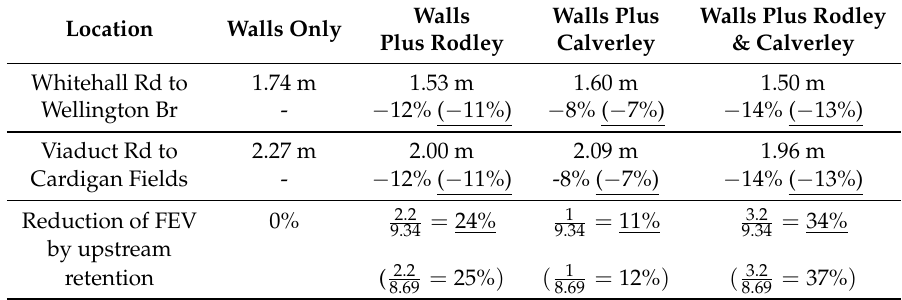
Table 3. The height of the defence walls proposed in FASII for protection against the 1:200-year flood and height reduction in percentage, along two different river stretches for the cases with only walls, walls with also the Rodley flood storage, or also the Apperley Railway Bridge/Calverley storage, or both. The wall-height reduction is given as a percentage for each location and can be compared against the extra flood-storage reduction percentage with respect to the flood excess volume (FEV) of V e = 9.34 Mm 3 chosen. Percentages relative to V eGRR = 8.69 Mm 3 are calculated by us, with an adjustment by a factor V eGRR / V e = 0.93 added in parentheses giving the percentage relative to V e , and wall heights are from a table in [21] based on Leeds City Council’s (LCC’s) calculations/simulations. The underlined percentages are used in FASII + . Walls Walls Plus Walls Plus Rodley Location Walls Only Plus Rodley Calverley &